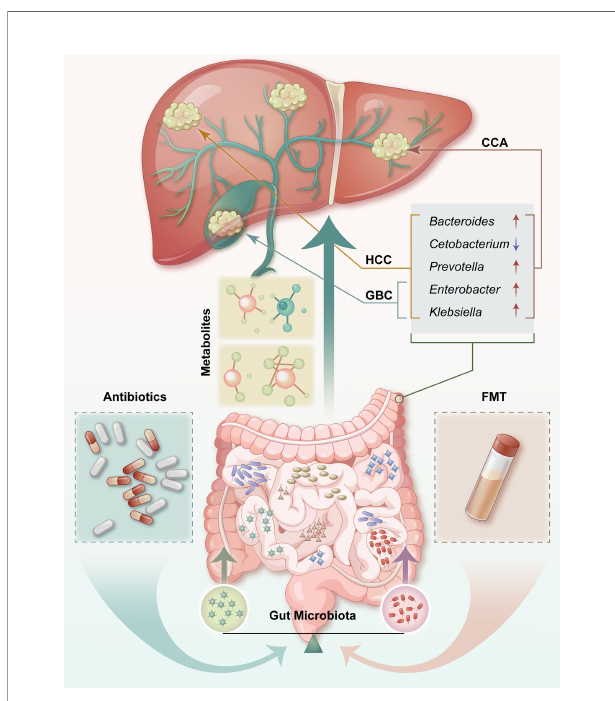
FIGURE 1 | Contributions of the microbiota of the gut to hepatobiliary tumors. There is an anatomical and physiological connection between the liver and the intestinal tract. Potential effective treatments or preventive strategies for HCC, including probiotics, antibiotics, and FMT, may be cost- effective. HCC, hepatocellular carcinoma; CCA, cholangiocarcinoma; GBC, gallbladder cancer; FMT, fecal microbiota transplant; ↑ = upregulated; ↓ =